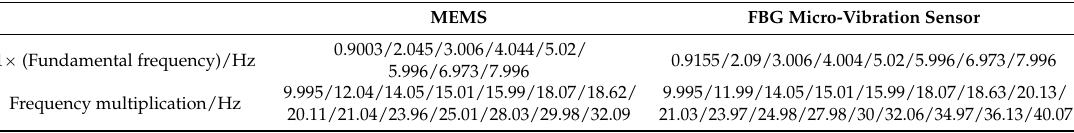
Table 2. Signals’ frequency components of the MEMS and FBG micro-vibration sensors for the scanning frequency experiments.